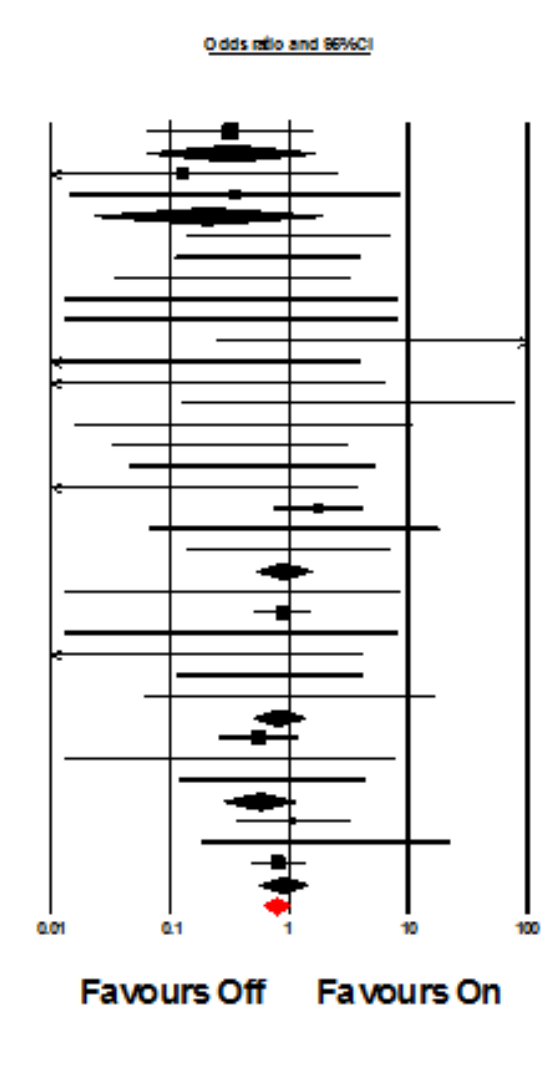
the 95% CI are equally dispersed about the line of no